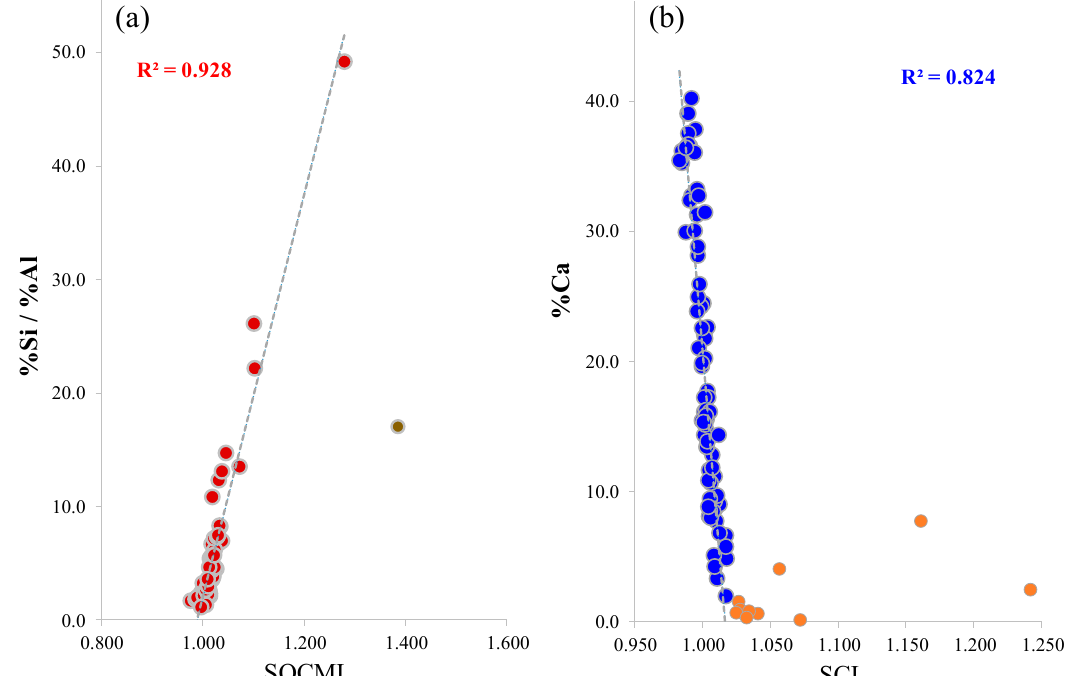
Figure 7. ( a ) Correlation between the % Si / % Al ratio and the calculated SQCMI value of all soil samples, excluding one brown–red sandy soil sample (brown circle). ( b ) Correlation between the % Ca values and the calculated SCI values of soil samples, excluding brown–red sandy soils (orange circles), characterized by relatively small amounts of carbonates.